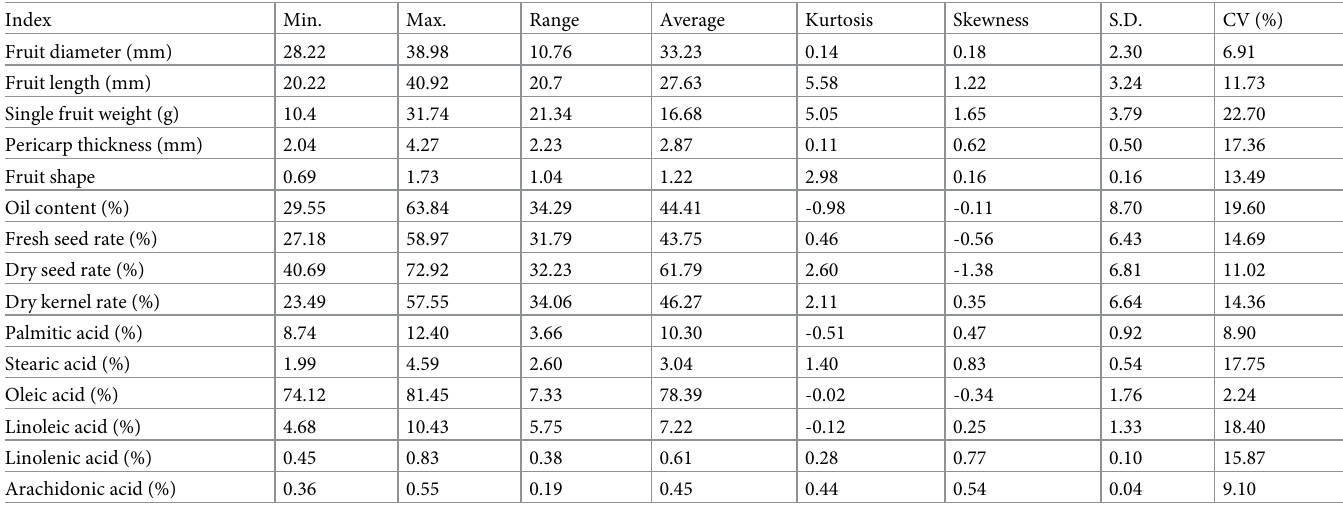
Table 1. Seed and fruit characteristics of the fruit of 45 superior Camellia weiningensis